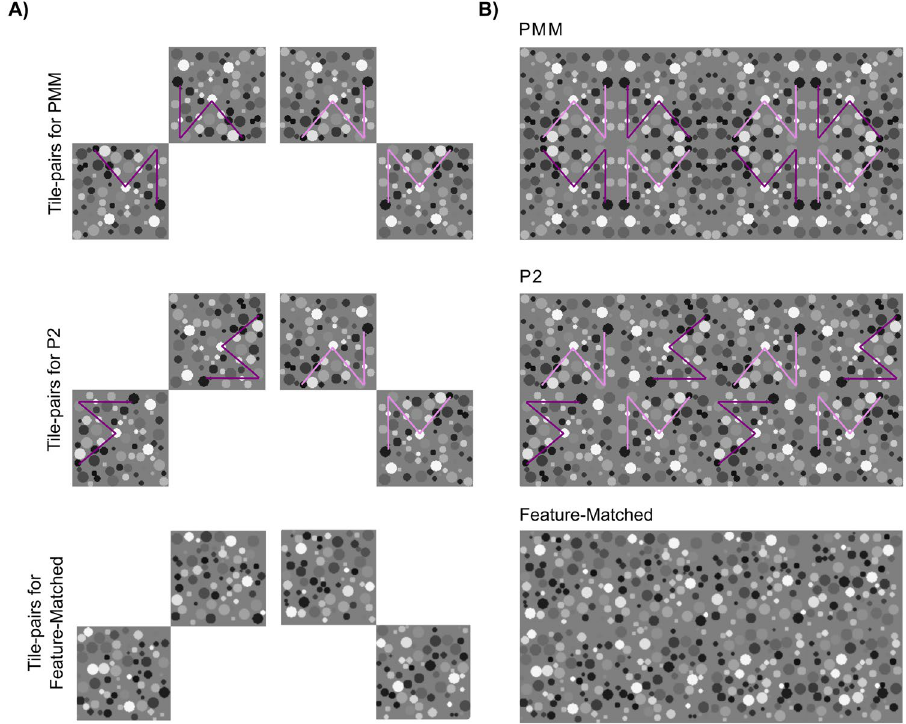
Figure 1. Tiles of all the patterns and three of the wallpaper pattern used in the experiment. ( A ) Tiles of each pattern type are shown. The local properties of individual dots (i.e. size, gray scale) were kept the same within the tile as well as across the three pattern types. ( B ) PMM, P2 and feature-matched patterns are shown. Note that both PMM and P2 included two 180° rotational symmetries within the diagonal parts of the unit-pattern, which were tagged with the same frequency. This is illustrated by the purple lines that can be seen within the diagonal pairs of both P2 and PMM tiles. The dark and light purple were used to differentiate the two different frequencies applied to diagonal halves and to highlight the rotation of one of the PMM tile pairs (dark purple) that is necessary for generating the P2 tiles. Please note that light and dark purple lines were not a part of the stimulus presentation, and are shown here to differentiate the two different frequencies applied to diagonal halves and to highlight the rotation of one of the PMM tile pairs (dark purple) that is necessary for generating the P2 tiles.